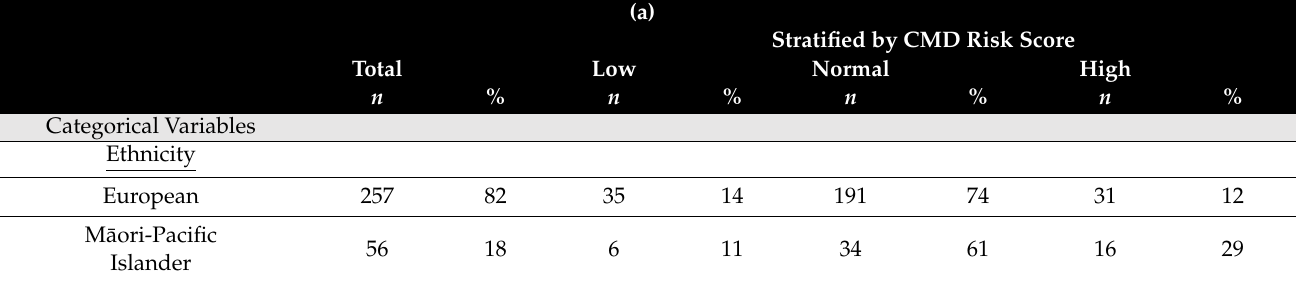
Table 1. (a) Overall and Risk Stratified Participant Characteristics for Categorical Variables. (b) Overall and Risk Stratified Participant Characteristics for Continuous